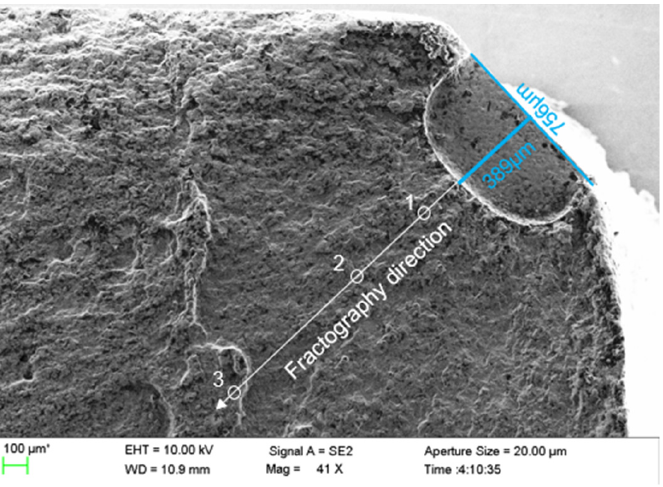
Figure 17. Typical optical image of a fracture surface for a crack emanating from an EDM notch.